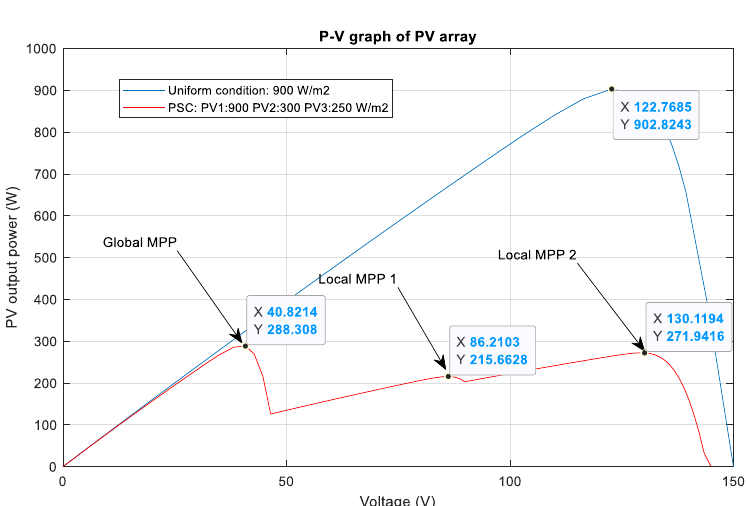
Figure 17. P–V curves of a PV array under uniform and partial shading Figure 17. P – V curves of a PV array under uniform and partial shading conditions.